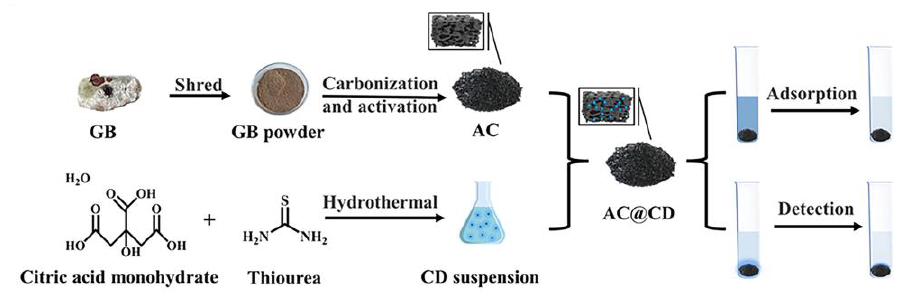
Figure 1. Synthetic schematic of AC@CD.